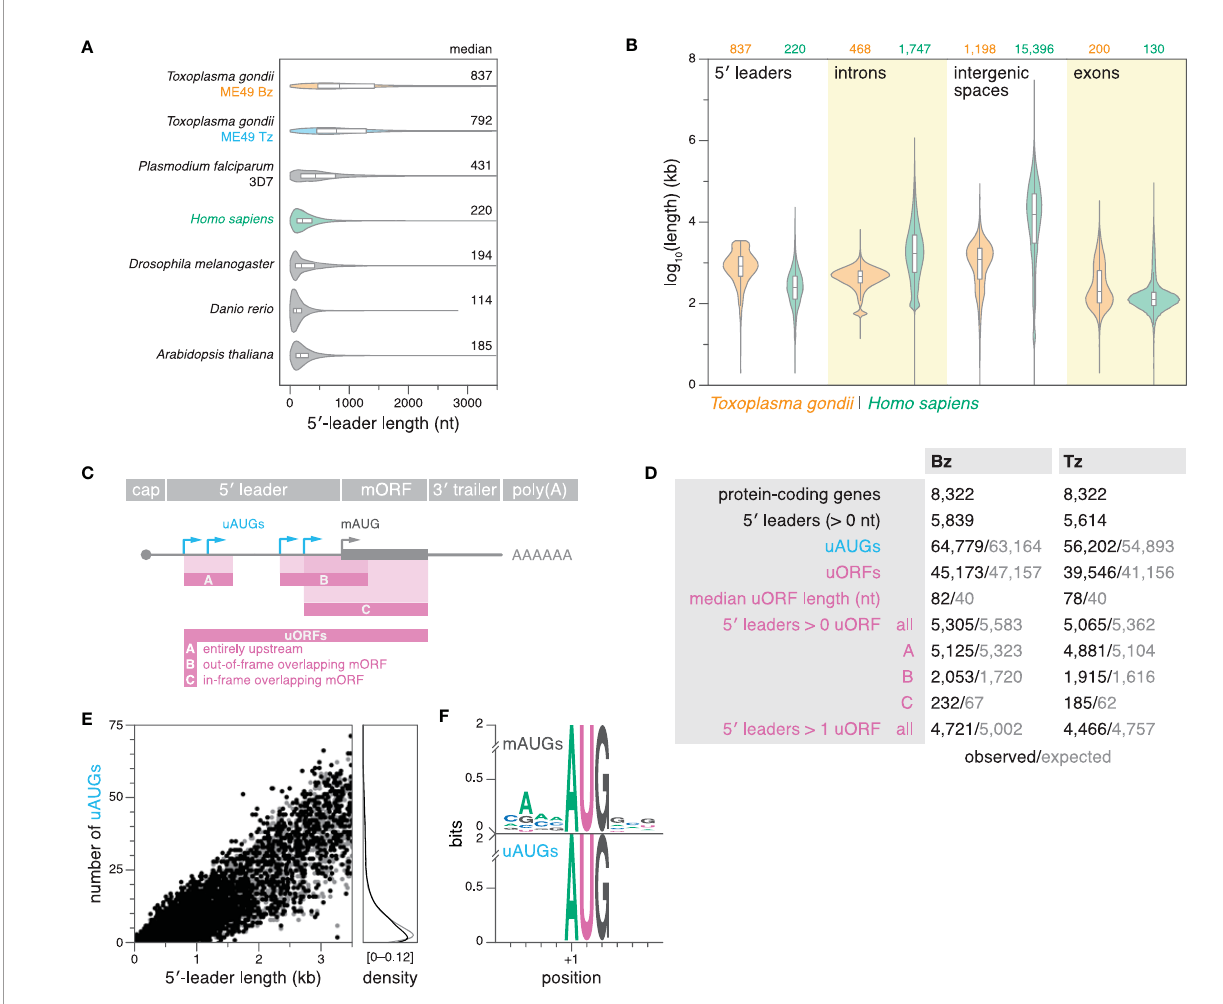
FIGURE 5 | Toxoplasma 5 ′ leaders are unusually long and lack suppression of upstream initiation triplets (uAUGs) and upstream ORFs (uORFs). (A) Violin and box plots showing the distribution of 5 ′ -leader lengths in various species. Outliers were removed for clarity. (B) Violin and box plots showing the length distributions of 5 ′ leaders (this study), introns, intergenic spaces, and exons in ME49 Bz and humans. Outliers are omitted for clarity. (C) De fi nitions of uAUGs and uORFs. uORFs have a minimum length requirement of nine nucleotides. In the case of multiple in-frame overlapping uORFs that share the same stop codon, only the longest was reported. (D) Summary statistics of uAUGs and uORFs in ME49 Bz and Tz. Simulated values represent the average of 15 different simulations, in which 5 ′ -leader sequences were individually shuf fl ed while maintaining dinucleotide frequency. Refer to previous panel for uORF categories. (E) Left, scatter plot showing the number of uAUGs per gene as a function of 5 ′ -leader length in ME49 Tz. Right, corresponding density plot. (F) Sequence logos of weighted position-speci fi c scoring matrices showing nucleotide conservation around mAUGs (top; n = 5614) and uAUGs of uORFs (bottom; n = 39546) in ME49